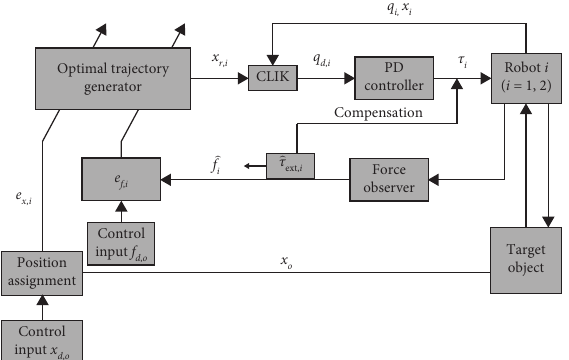
Figure 1: The whole system structure of the bimanual robot manipulation.